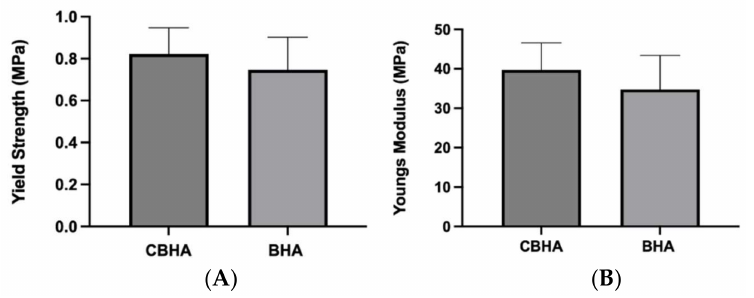
Figure 11. Mechanical properties of the CBHA and BHA scaffold. ( A ) Yield strength ( n = 15, p = 0.7068). ( B ) Young’s modulus ( n = 15, p = 0.6547). Bar graphs were reported as ± standard error of the mean